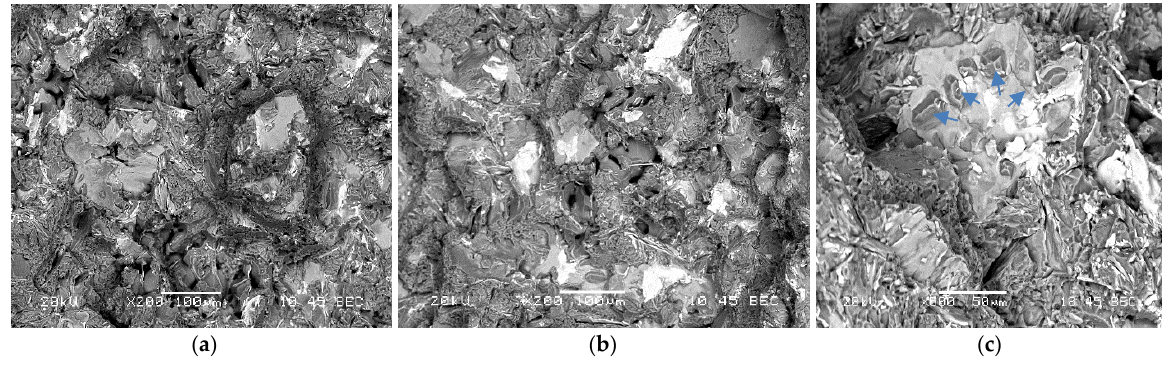
Figure 17. Fracture surface of M3S alloy in: ( a ) as cast, ( b ) SHT, and ( c ) T6 conditions. Blue arrows in ( c ) point to perforation of the AlSiMnFe-based